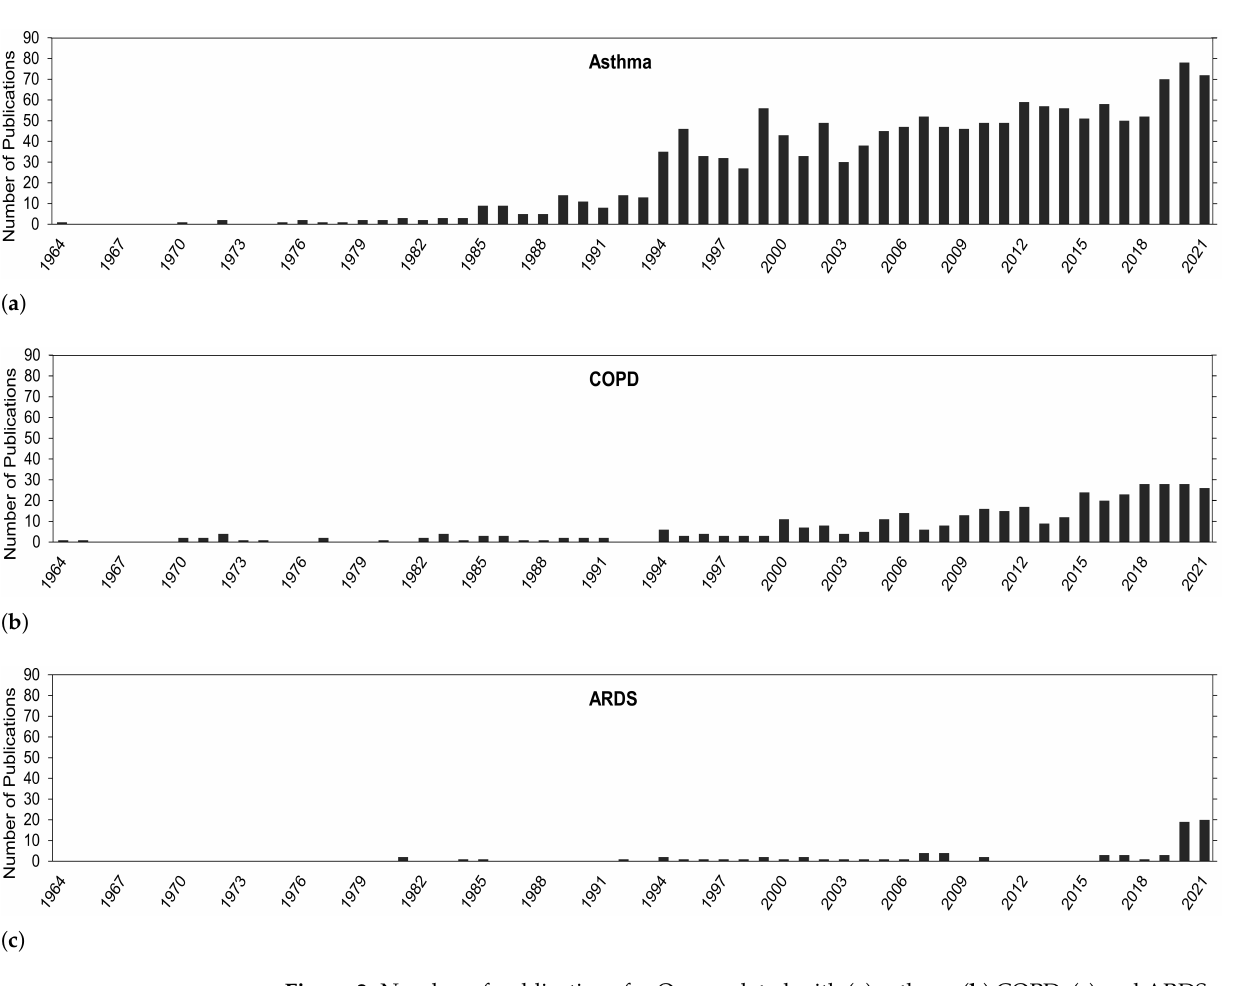
Figure 2. Number of publications for O 3 correlated with ( a ) asthma, ( b ) COPD, ( c ) and